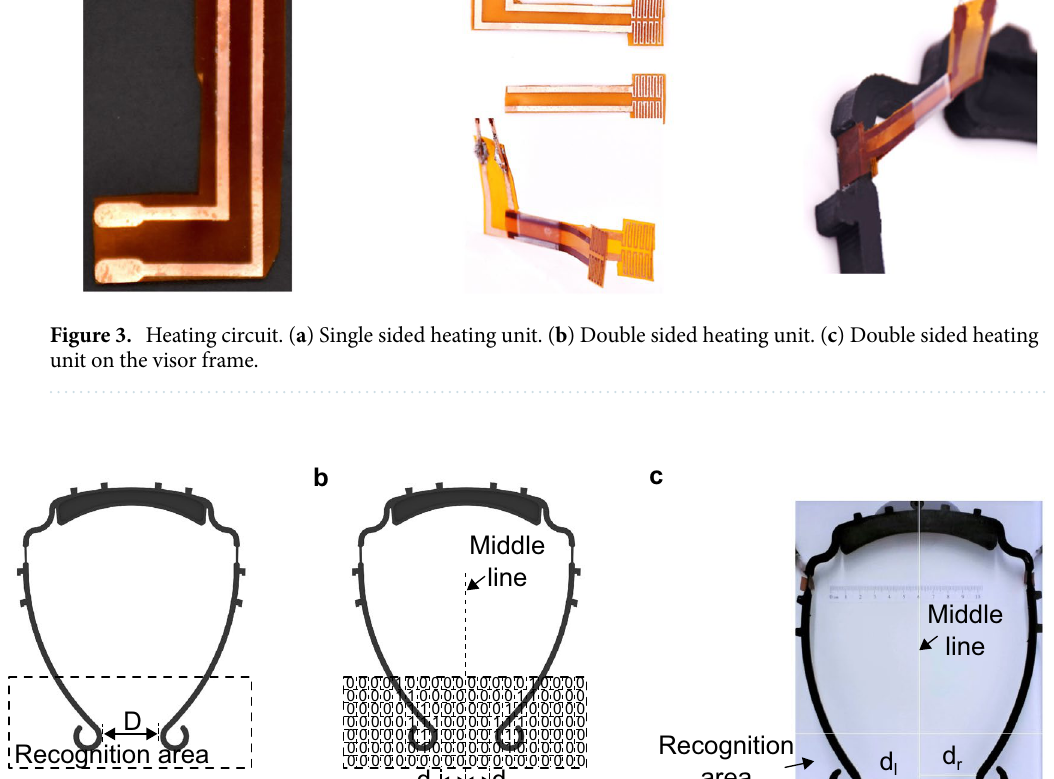
areaD Recognition